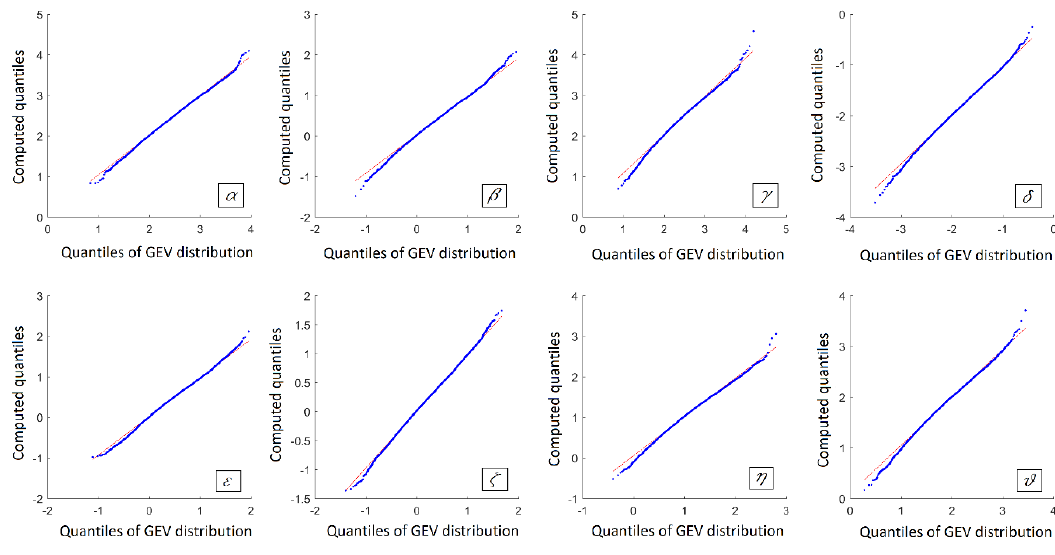
Figure 7. Q–Q plots of NDWI m parameters.